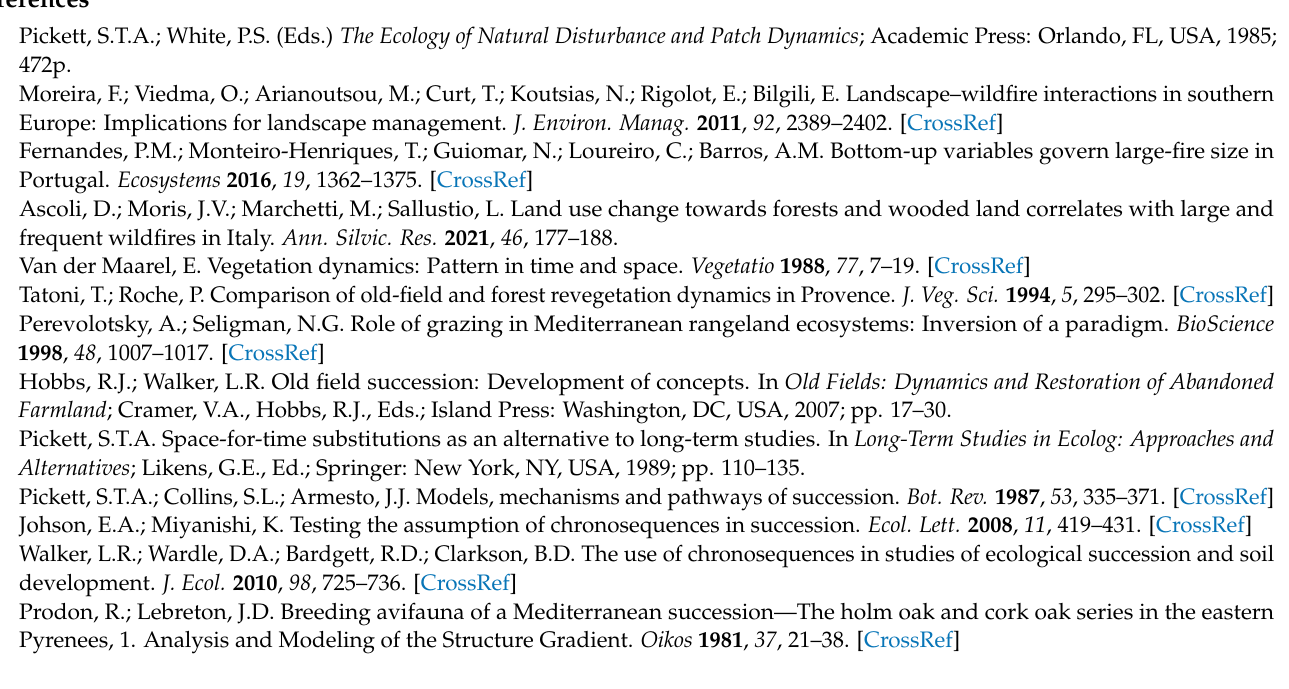
Figure A6. Postfire trajectories of some study stations in the plane defined by the two first axes of correspondence analysis of the bird matrix. Each small black square corresponds to an annual survey (the maximum monitoring duration is specified). Large black squares: prefire surveys, red triangles: first postfire surveys, green diamonds: end of the chronosequences (the number of years is indicated). ( a , b ): low maquis, ( c ): Erica arborea and E. scoparia maquis, ( d ): holm oak stand, ( e ): cork oak stand, ( f ): repeated surveys in an unburned cork oak stand (blue) and a holm oak stand (green). The large black square in ( d ) corresponds to a nearby unburned control.